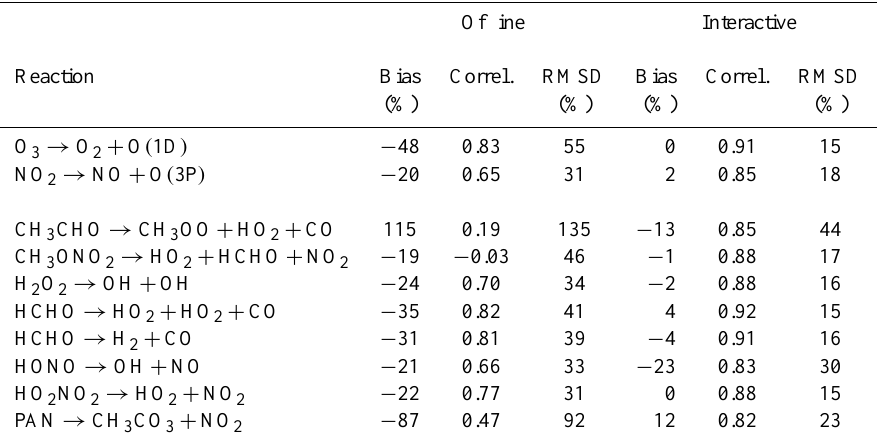
Table 2. Quantitative comparison between photolysis rates from INTEX data and modelled rates with interactive and offline photolysis using all flights (1 July 2004 to 15 August 2004). Offline Interactive Reaction Bias Correl. RMSD Bias Correl. RMSD (%) (%) (%) (%) O 3 → O 2 + O ( 1D ) − 48 0.83 0 NO 2 → NO + O ( 3P ) −